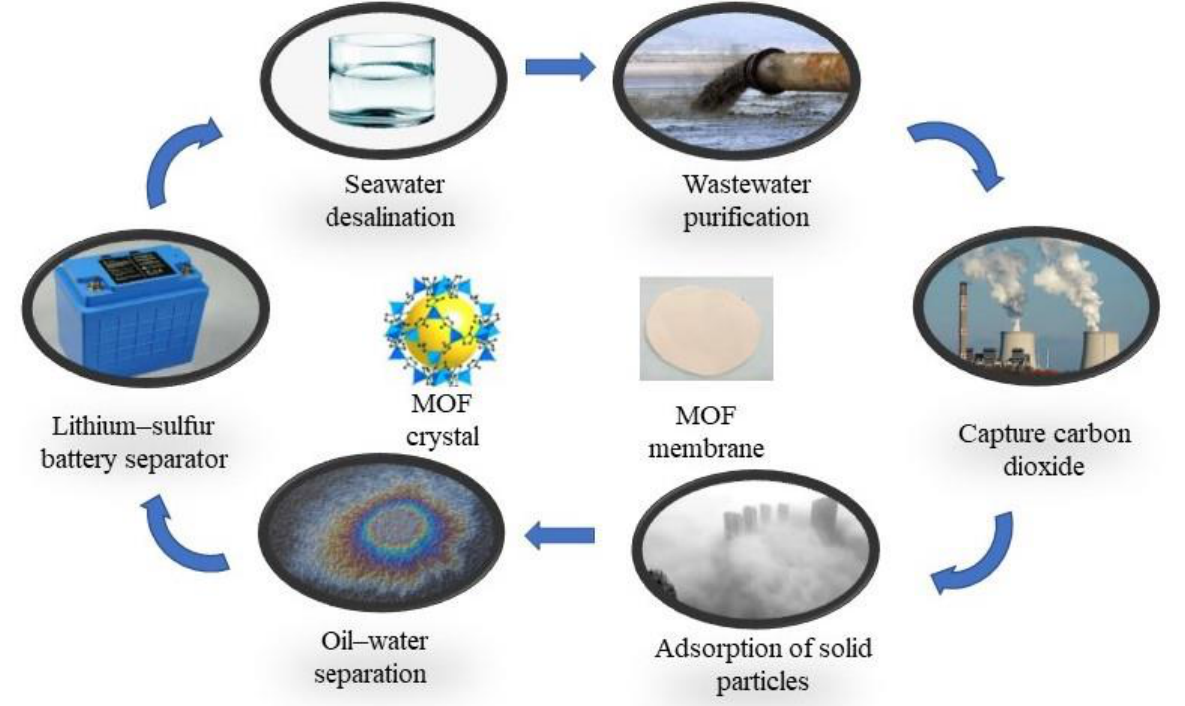
Figure 4. MOF crystal, MOF membrane, and applications of MOF membranes.